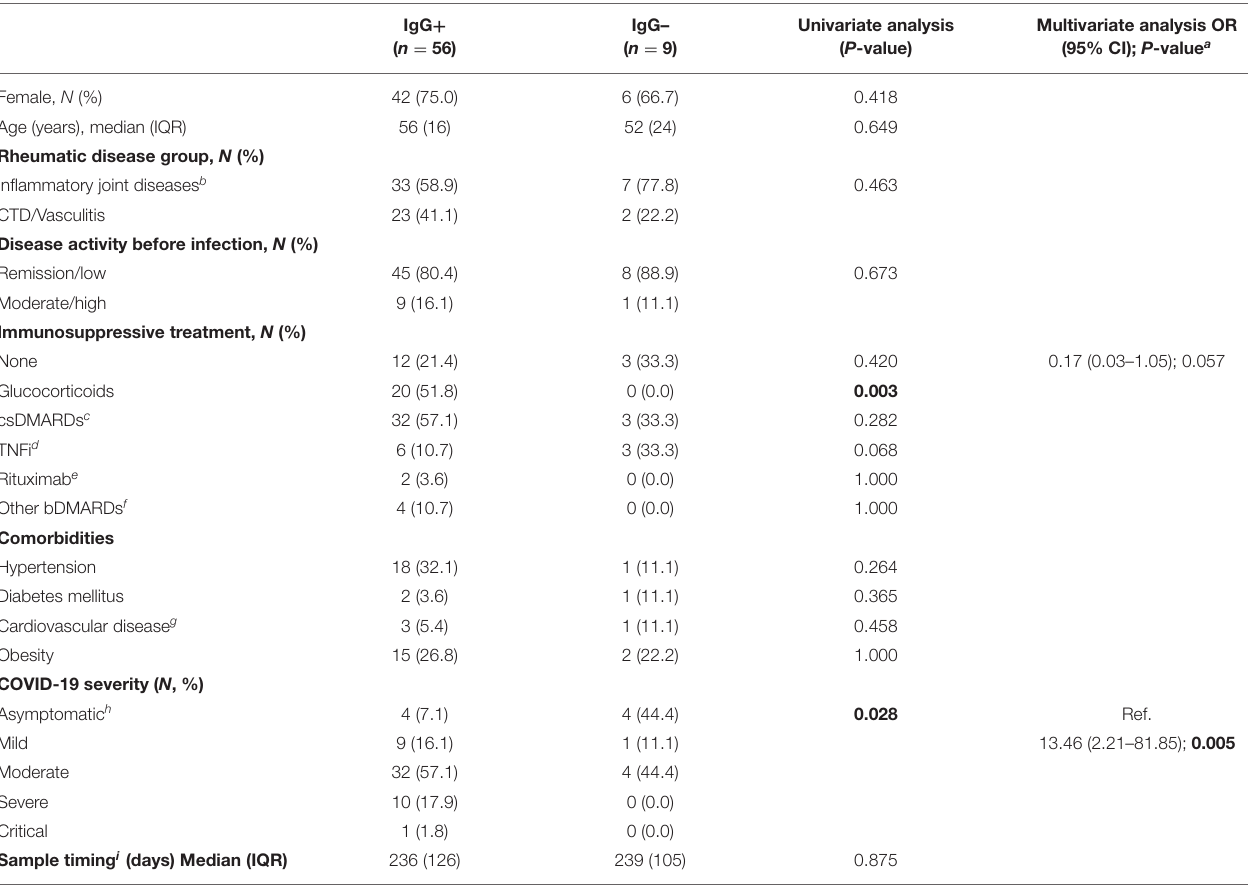
TABLE 5 | Comparison of COVID-19 + patients based on antibody response.